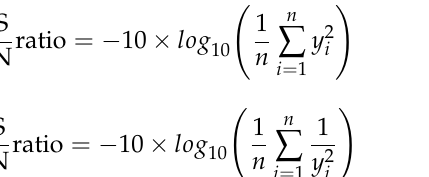
( b ) Figure 2. ( a ) Surface roughness testing machine; ( b ) SEM of tool wear. 2.2. Optimization Methodology Figure 3 shows the steps followed for single ‐ and multi ‐ response optimization using Taguchi signal ‐ to ‐ noise (S/N) ratios and the combinative distance ‐ based assessment (CO ‐